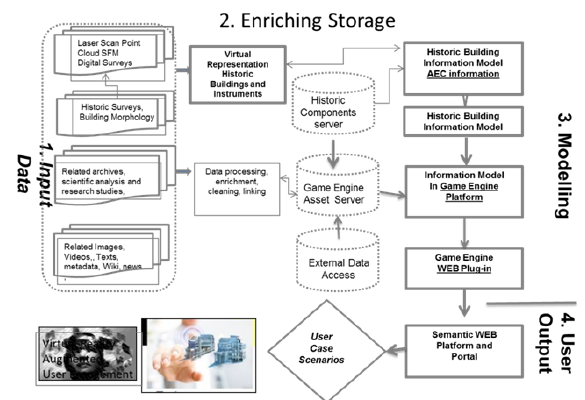
Figure 11: Systems Architecture for